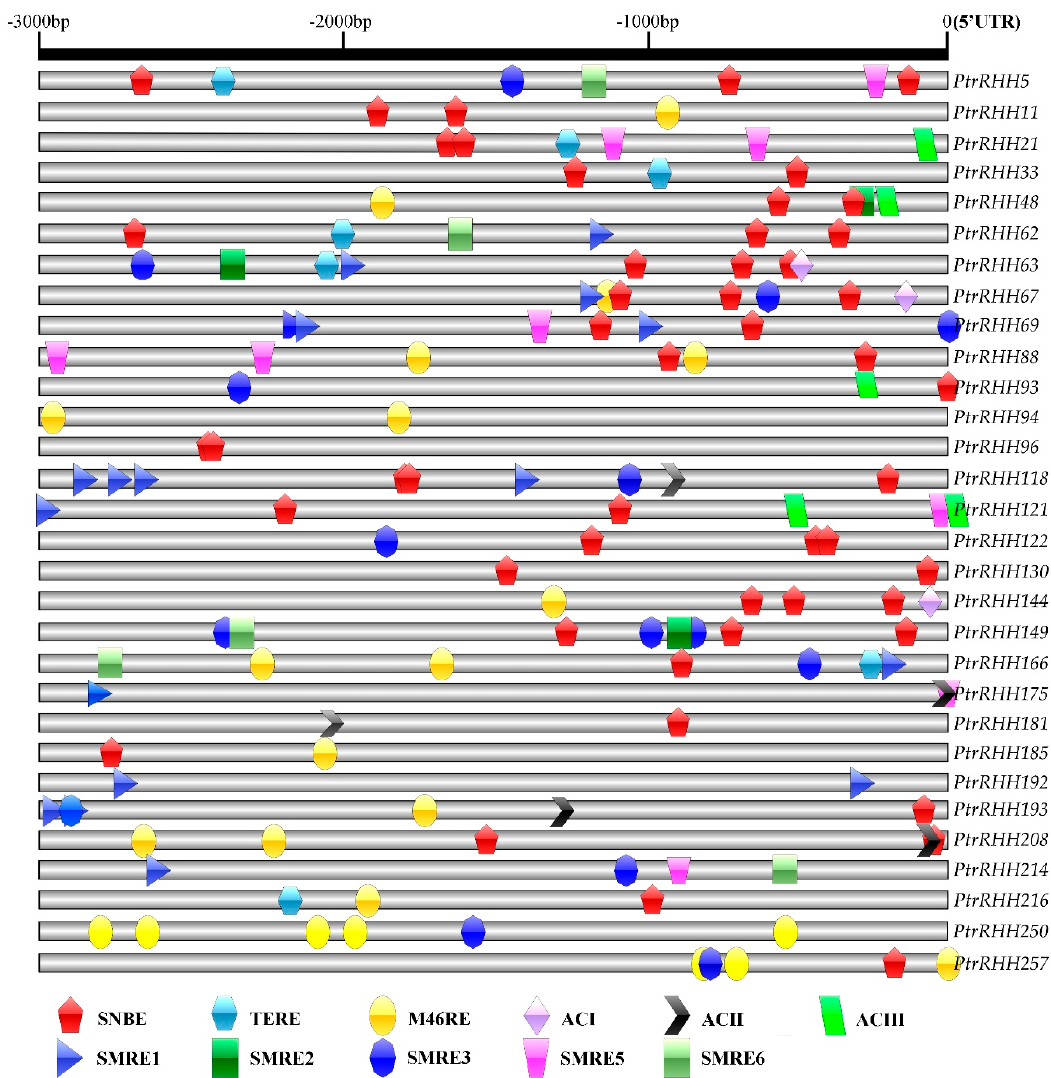
Figure 5. Xylem development-related cis-elements in the promoter regions of the RING-H2 genes highly or preferentially expressed in xylem. Different cis-elements were exhibited by different shapes with different colors.